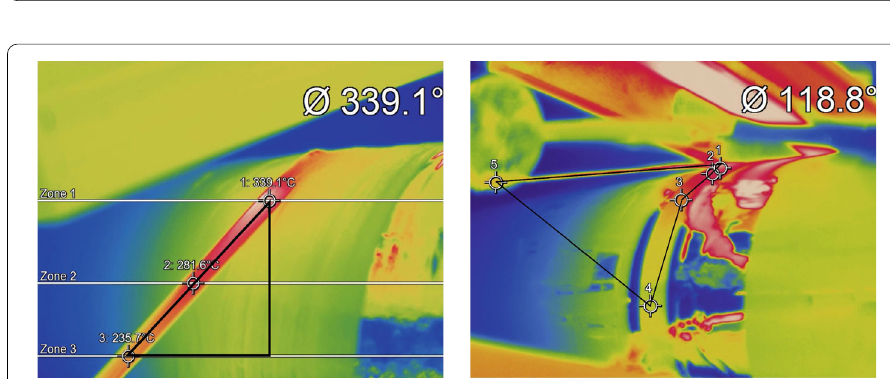
Fig. 1 The ATP winding process with the three radiative heat sources marked as RHS 1 and RHS 2 , the incoming tape temperature is T in , the cylindrical deposition base has a radius R c = 54mm and a controlled temperature T b